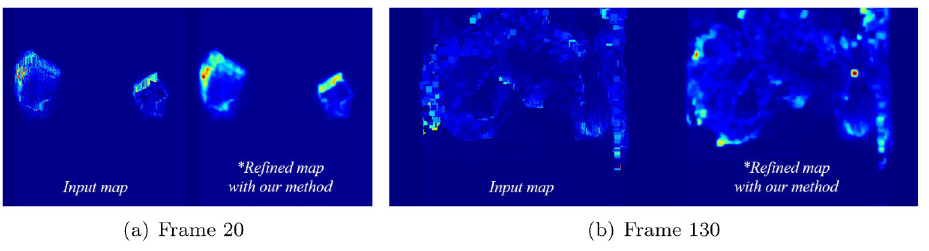
Fig 12. Refinement of acceleration map with our method (red: Fast flow zone). (a) Frame 20, (b) Frame 130.